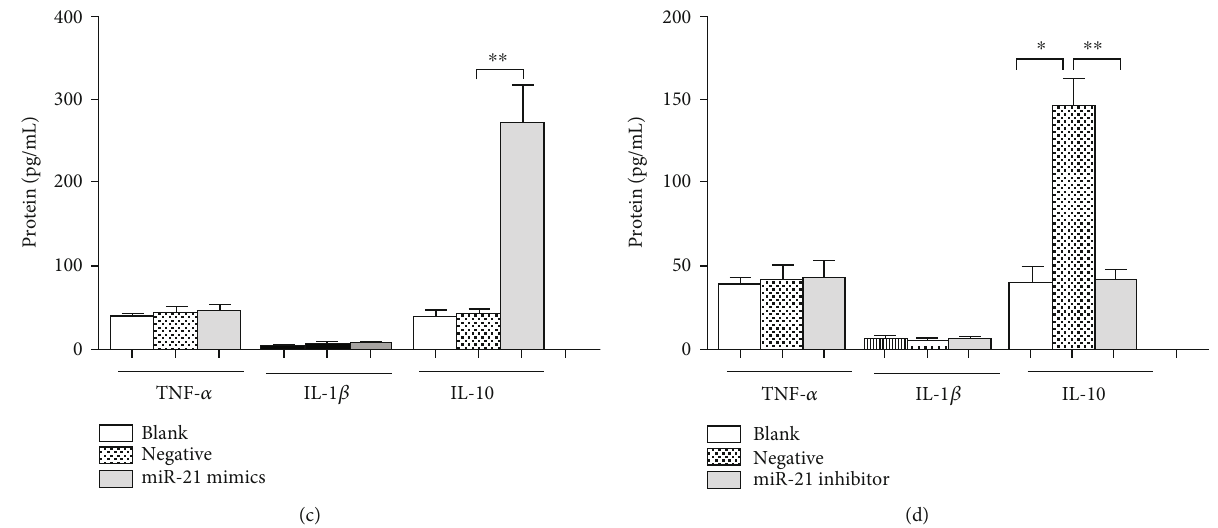
Figure 5: KLE-cell derived exosomal miRNA-21 promoted M2-like polarization of THP-1 monocytes under hypoxia condition. (a) miRNA-21 mimics or negative control was transfected into THP-1 cells for 24h. The statistical assay of TNF- α , IL-1 β , IL-10, and CD206 mRNA expression in THP-1 cells. (b) miRNA-21 inhibitor and negative control were introduced to the THP-1 cells and then cocultured with exosomes derived from hypoxic KEL cells. The statistical assay of TNF- α , IL-1 β , IL-10, and CD206 mRNA expression in THP-1 cells. (c) The experiment is the same as (a). The statistical assay of the protein levels of TNF- α , IL-1 β , and IL-10. (d) The experiment is the same as (b). The statistical assay of the protein levels of TNF- α , IL-1 β , and IL-10 in the supernatants. The results represent three independent experiments. ∗ P < 0 : 05 , ∗∗ P < 0 : 01